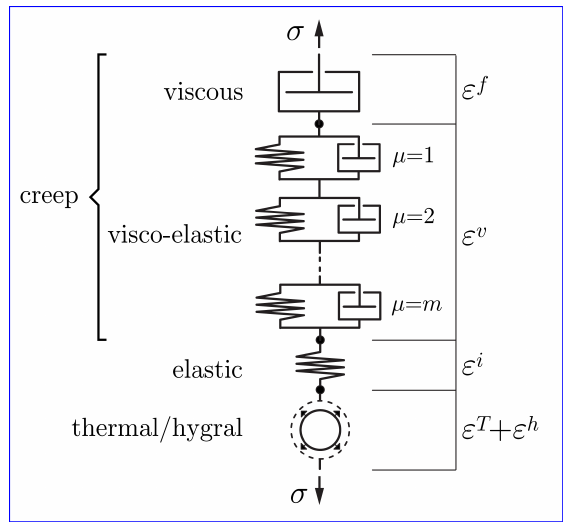
Figure 5. Series construction of total strain